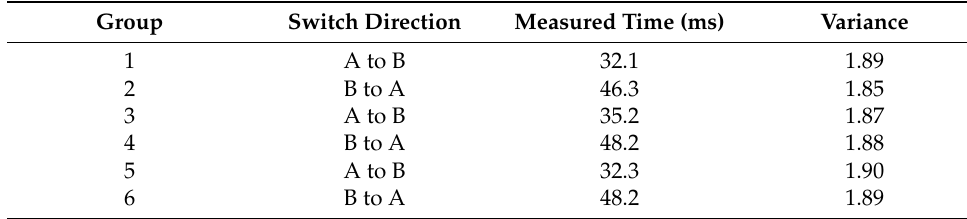
Figure 14. Refueling situation response under different given values. Table 2. Test record of dual-redundant NIC